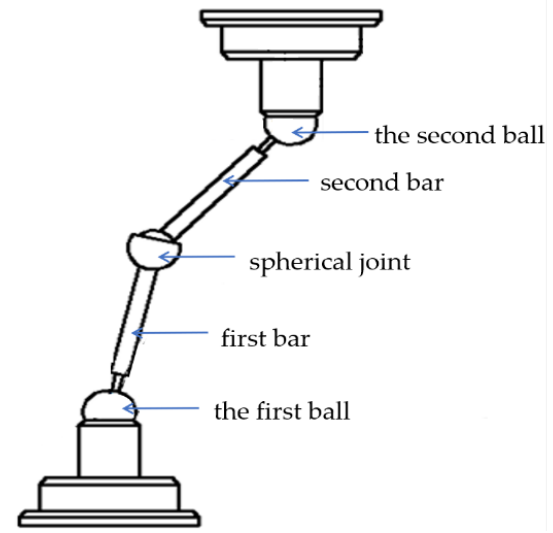
Figure 1. Structure of the J-DBB.